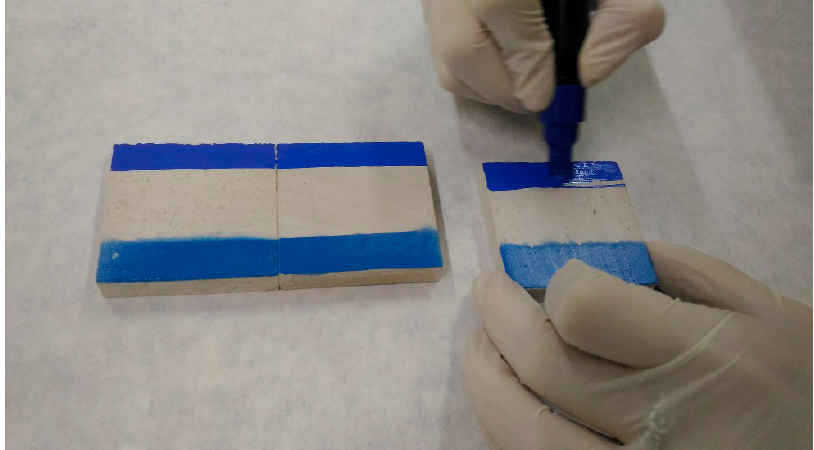
Figure 5. Staining by felt-tip marker.